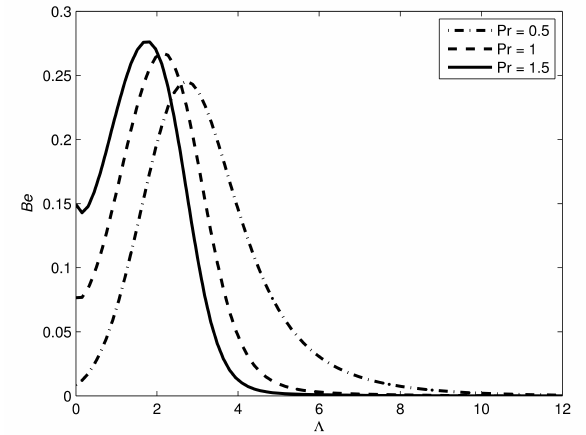
Figure 28: Effect of Pr on Be keeping ζ = η = 0.2 , C 1 = C 2 = C 3 = 10 , Br = 1 , Re = 2950 , σ 1 = 1 , σ 2 = 0.5 , Q 0 = 0.5